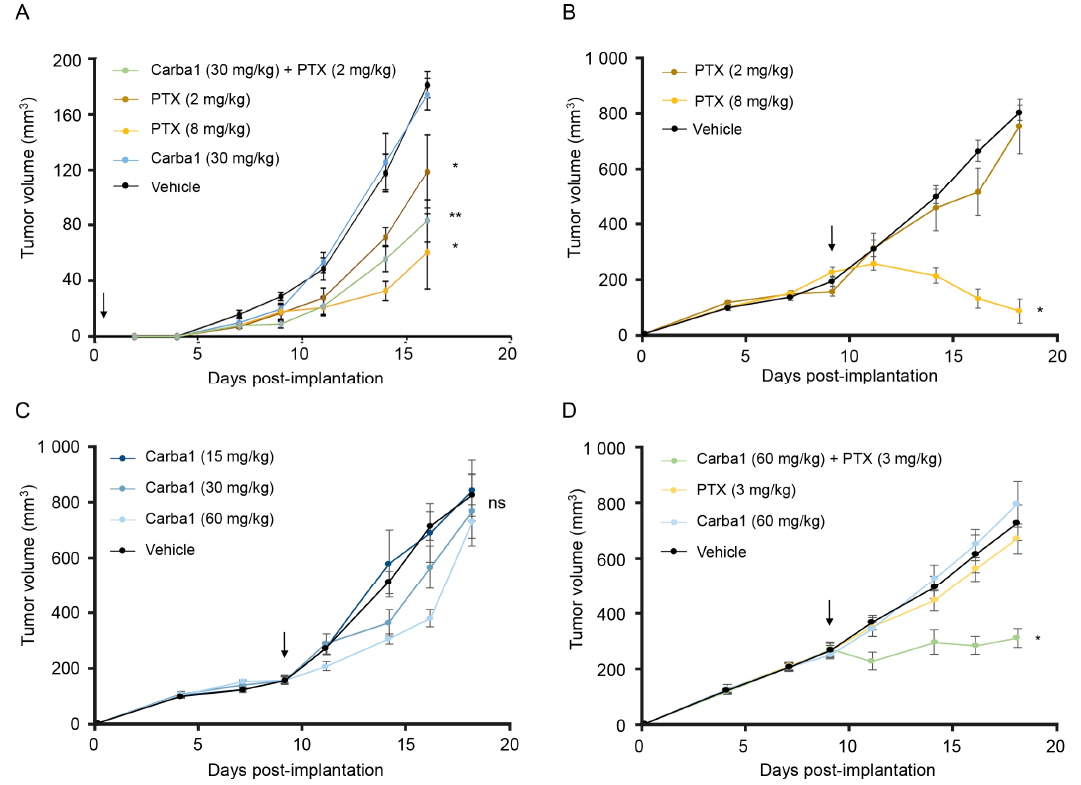
Figure 7. Carba1 acts synergistically with PTX to reduce tumor growth in vivo. ( A ) Exploratory analysis of the e ff ect of PTX, Carba1, and their combination on the growth of 4T1 cells allografted in mice. Mice were treated with PTX (2 and 8 mg / kg), Carba1 (30 mg / kg), the combination of PTX (2 mg / kg) and Carba1 (30 mg / kg), or the vehicle. Tumor growth was monitored with a sliding caliper. Data represent a median. Error bars = MAD, * p < 0.05, ** p < 0.01 compared to vehicle (Kruskal–Wallis), n = 8 mice per group. ( B ) PTX inhibits the growth of HeLa cells xenografted in mice. When the tumors have reached a volume of about 200 mm 3 , mice were treated with PTX (2 and 8 mg / kg) or the vehicle. Tumor growth was monitored with a sliding caliper. Error bars = SEM, * p < 0.01 compared to vehicle (ANOVA), n = 6 mice per group. ( C ) Carba1 has no significant e ff ect on the growth of HeLa cells xenografted in mice. When the tumors have reached a volume of about 200 mm 3 , mice were treated with Carba1 (15, 30, and 60 mg / kg) or the vehicle. Tumor growth was monitored with a sliding caliper. Error bars = SEM, ns = non-significant (ANOVA), n = 6 mice per group. ( D ) The combination of otherwise ine ff ective doses of Carba1 and PTX inhibits the growth of HeLa cells xenografted in mice. When the tumors have reached a volume of about 200 mm 3 , mice were treated with PTX (3 mg / kg), Carba1 (60 mg / kg), the vehicle, or the combination of PTX (3 mg / kg) and Carba1 (60 mg / kg). Tumor growth was monitored with a sliding caliper. Error bars = SEM. * p < 0.001 compared vehicle (Student’s t -test), n = 8 mice per group. Arrows indicate the onset of the treatments.